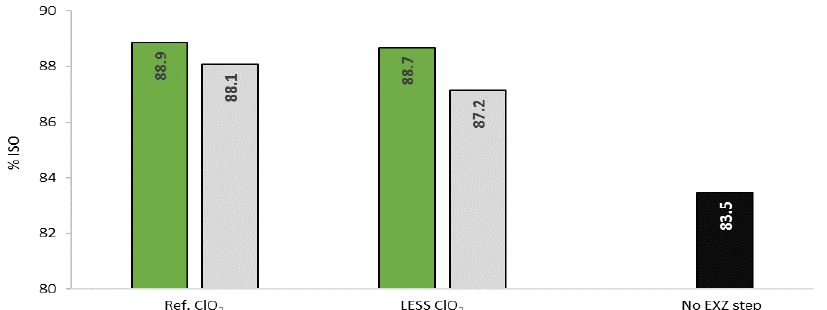
Figure 6. Comparison of pulp brightness obtained after 3 h pretreatment with Xyn11 (green) or without enzyme (control, grey) followed by conventional bleaching sequence applying reference or 15% less ClO 2 loadings; and with 15% less ClO 2 but without EXZ step (No EXZ step, black).